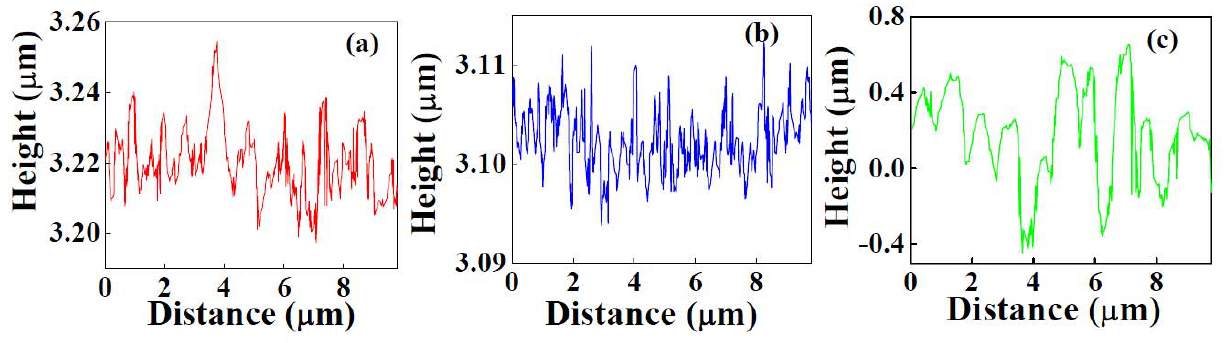
O coating, ( b ) thermally 2 3 O 2 3